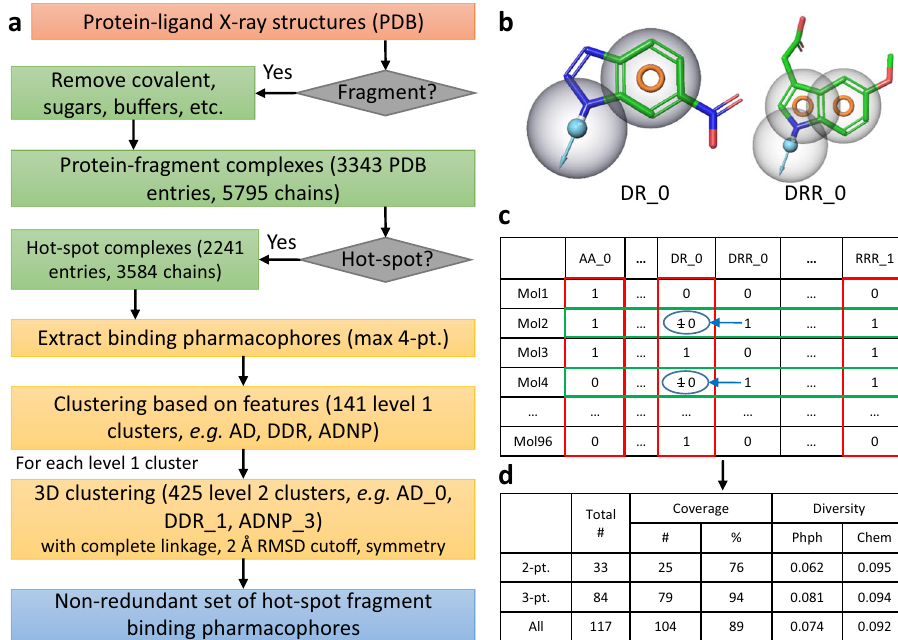
Fig. 1 SpotXplorer work fl ow. a Computational work fl ow for assembling the non-redundant set of fragment binding pharmacophores. Fragment-sized 15 ligands from the Protein Data Bank (PDB) were subjected to large-scale FTMap 16, 17 analysis to identify hotspot binding fragments. Pharmacophore features (A — H-bond acceptor, D — H-bond donor, H — hydrophobic group, N — negative charge, P — positive charge, R — aromatic ring, see Supplementary Information, section 1.7 for more detail) with the largest contributions to the overall free energy of binding were clustered based on their respective feature sets and binned by paired root-mean-square deviation (RMSD) values (e.g., DRR_0, with 0 being an arbitrarily assigned identi fi er). b Pharmacophore models overlaid onto the co-crystallized representative ligand of the cluster. For each fragment fi ngerprint generated, fi t to a larger model necessarily includes smaller models. Here, DR_0 can be fi tted onto the corresponding features of DRR_0; the former is a submodel of the latter. c Compound selection algorithm. Iterative minimization of both the mean pairwise fi ngerprint similarity (green rows) and pharmacophore similarity (red columns) with submodels set to zero and simultaneous maximization of the total number of represented pharmacophores generated the SpotXplorer0 pilot library (96 compounds). d Final coverage and distribution data of the 96-compound set selected using 2-point and 3-point pharmacophores (along with the